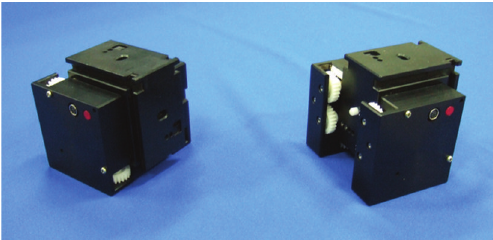
Figure 1: External view of the modules of CHOBIE